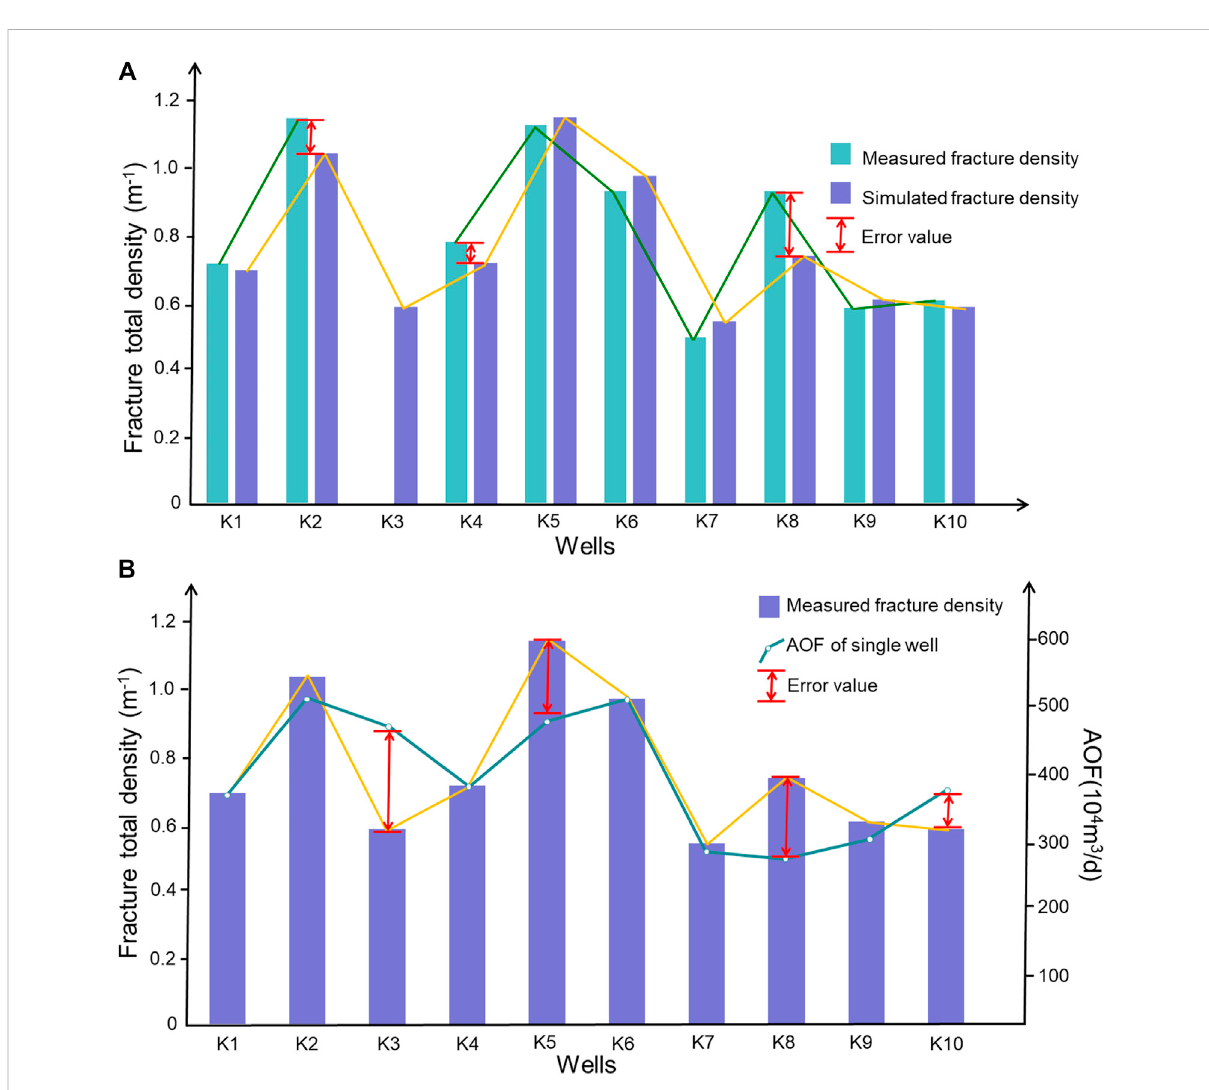
Frontiers in Earth